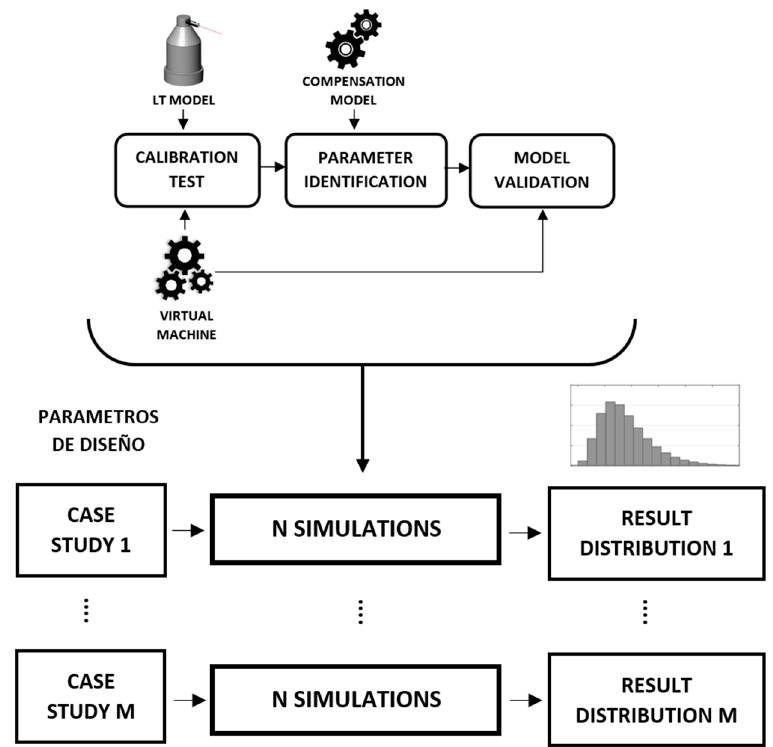
Figure 1. Process diagram for the whole calibration and compensation procedure comparing several case studies .